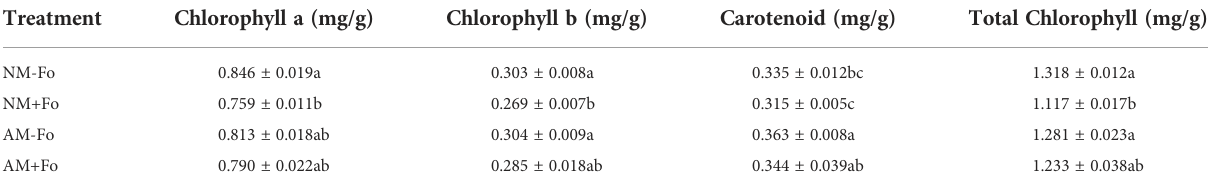
Values are means ± SD from four sets of independent experiments with 15 plants. Different lowercase letters indicate signi fi cant differences between different treatments according to two- way ANOVA followed by Tukey ’ s test for multiple comparisons (P < 0.05).